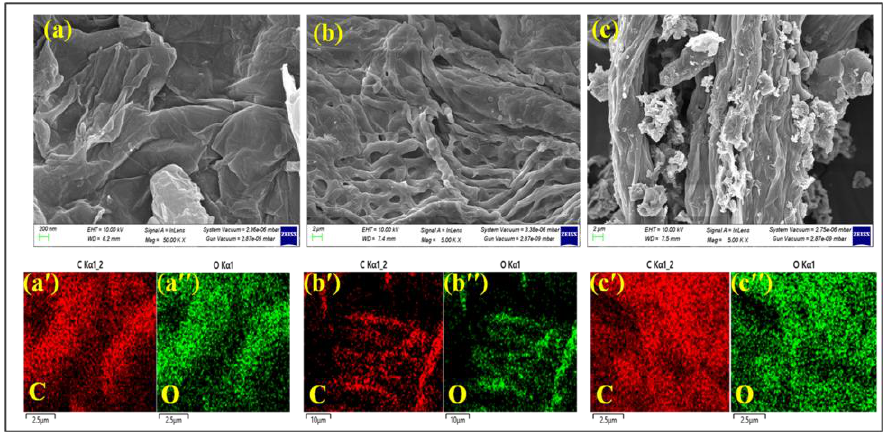
Figure 3. FE-SEM image ( a ) and elemental mapping of C ( a’ ) and O ( a” ) of GO, ( b ) elemental map- ping of C ( b’ )and O ( b” ) of extracted cellulose, and ( c ) elemental mapping of C ( c’ ) and O ( c” ) of GO–cellulose composite.